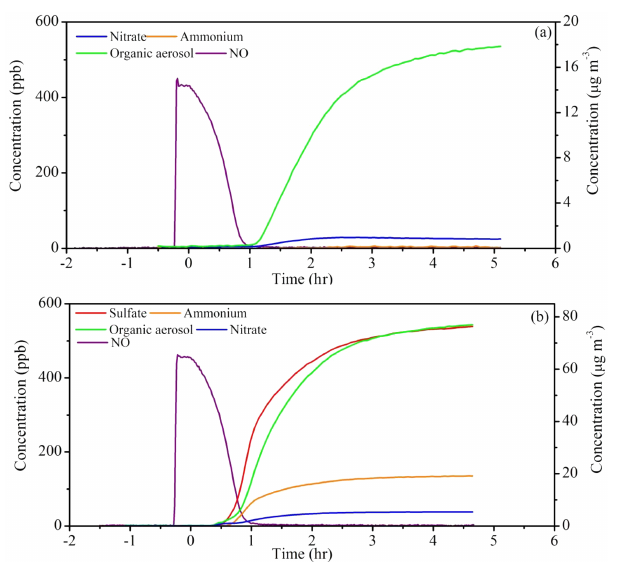
Figure 2. Concentration–time plots of NO (left y axis) and particle- phase species (right y axis) during the photochemical aging of emissions from vehicle III. (a) Without and (b) with SO 2 . The concentrations of particle-phase species are wall-loss-corrected. At time = 0h, the black lamps were turned on.